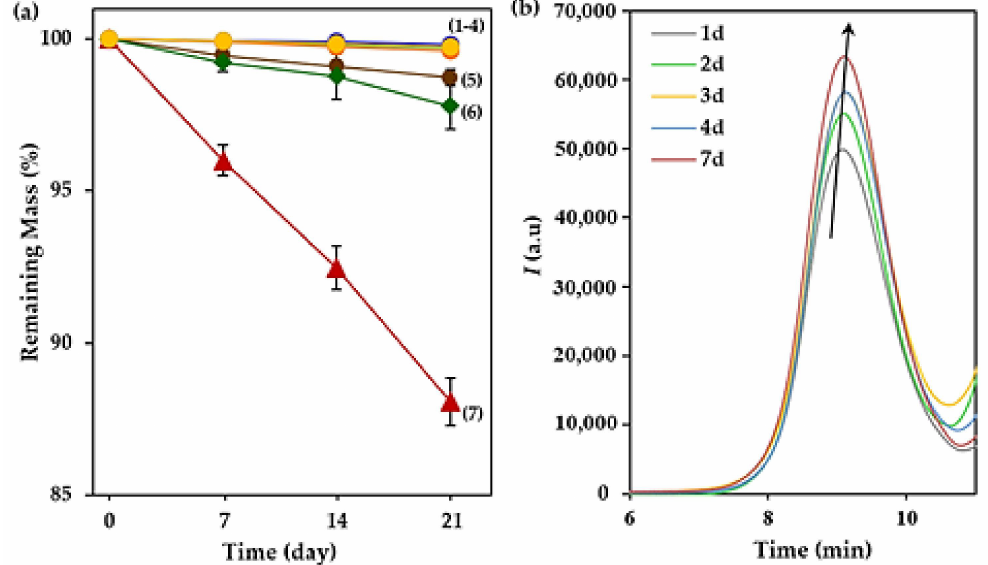
Figure 8. ( a ) Degradation of poly(PA-LO) as a function of time at different conditions: Hydrolytic degradation at pHs 3, 7 and 10 (curves 1–3), lipase enzymatic degradation (curve 4) and esterase enzymatic degradation (curve 5) at 37 ◦ C, degradation in the basic pH 10 medium at 70 ◦ C (curve 6) and degradation in oxidative media of H 2 O 2 at 37 ◦ C (curve 7). Weight losses were close to 0.5%, 1.5%, 2.7% and 12% for curves 1–4, curve 5, curve 6 and curve 7, respectively. ( b ) GPC curves taken for poly(PA-LO) during exposure to the esterase enzymatic